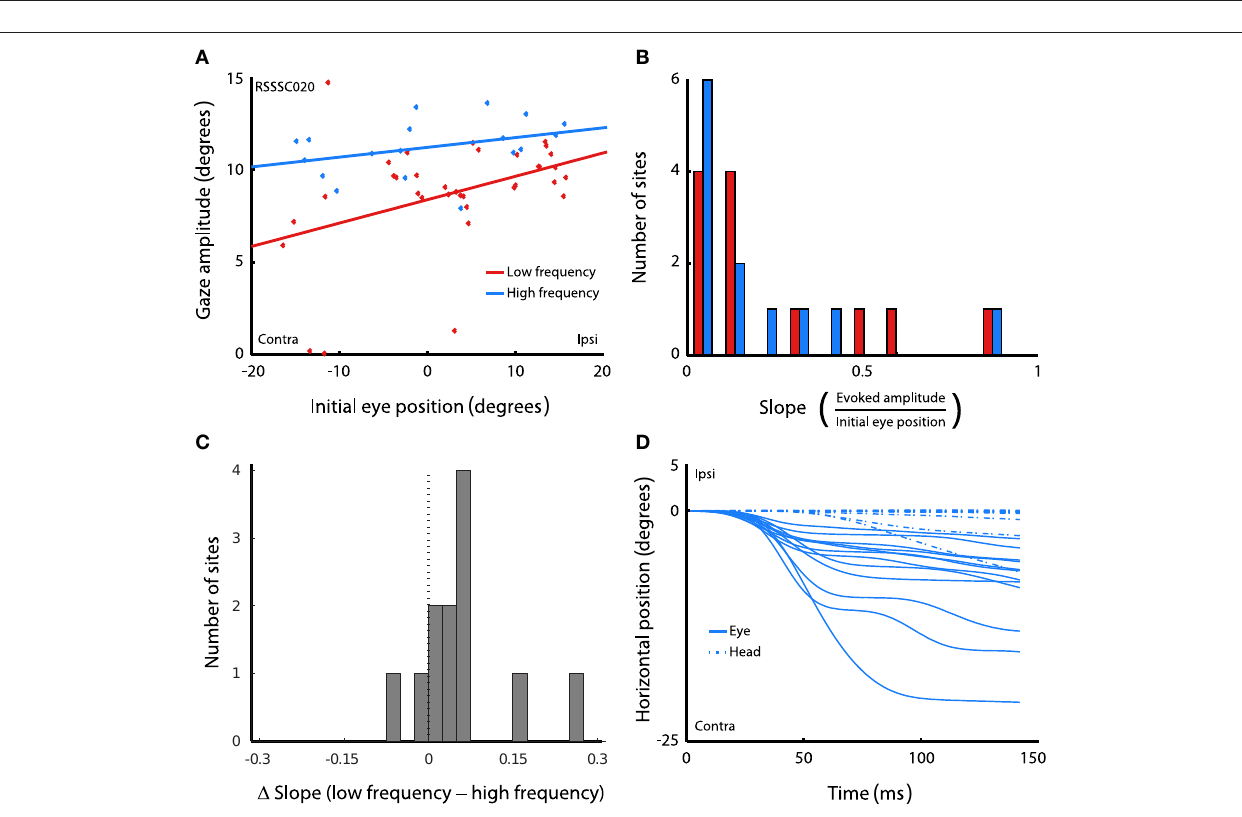
FIgure 5 | relation between eye position dependence and saccade amplitude. (A) Average saccade vector for each stimulation site, averaged across all stimulation frequencies and initial fixation positions. (B) Magnitude of the slope obtained from linear regression of saccade amplitude on initial eye